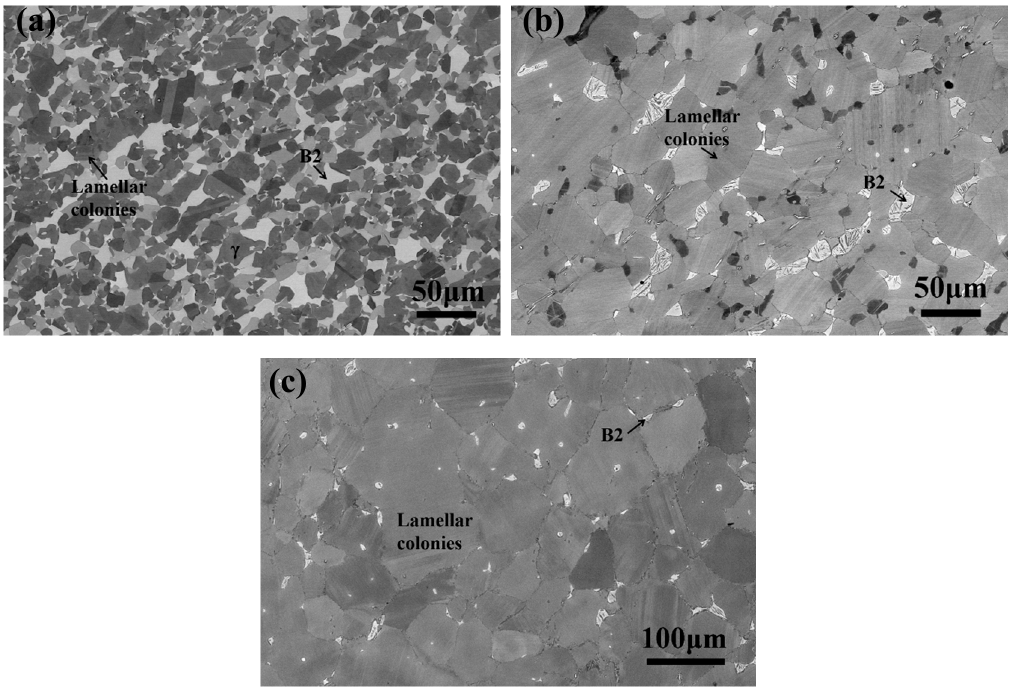
Figure 1. Back scattered electron (BSE) images of TNM alloys with different microstructures: ( a ) DP alloy; ( b ) NL#1 alloy; and ( c ) NL#2 alloy.